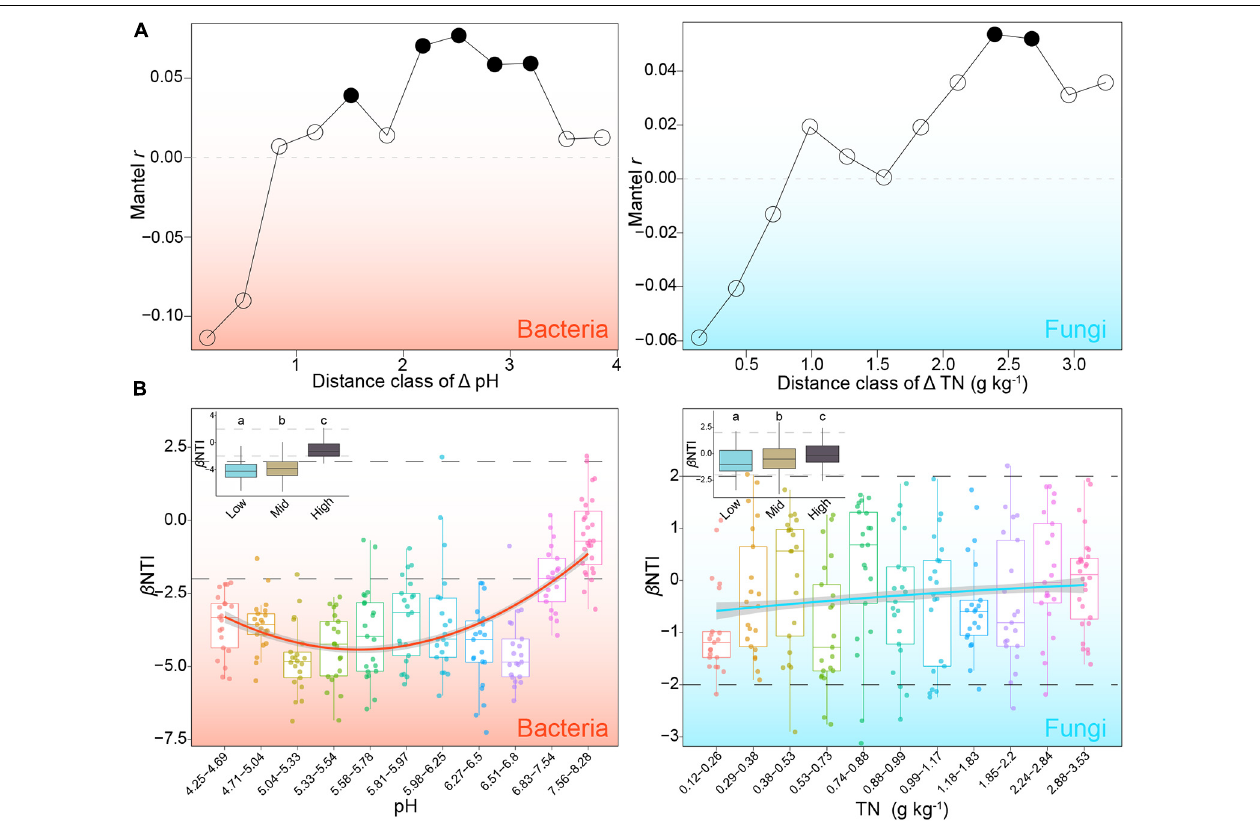
FIGURE 4 | Main factors mediating the relative contributions of stochastic and deterministic processes to bacterial and fungal community assembly. (A) Mantel correlograms of β -nearest taxon index ( β NTI) against distance classes of key variables (i.e., pH for bacteria and TN for fungi) identified by mantel and partial mantel tests. Solid dots represent significant correlation at corresponding distance class. (B) Patterns of β NTI across different sub-groups along gradients of pH for bacteria and TN for fungi. Solid lines represent least-square regression with a second order